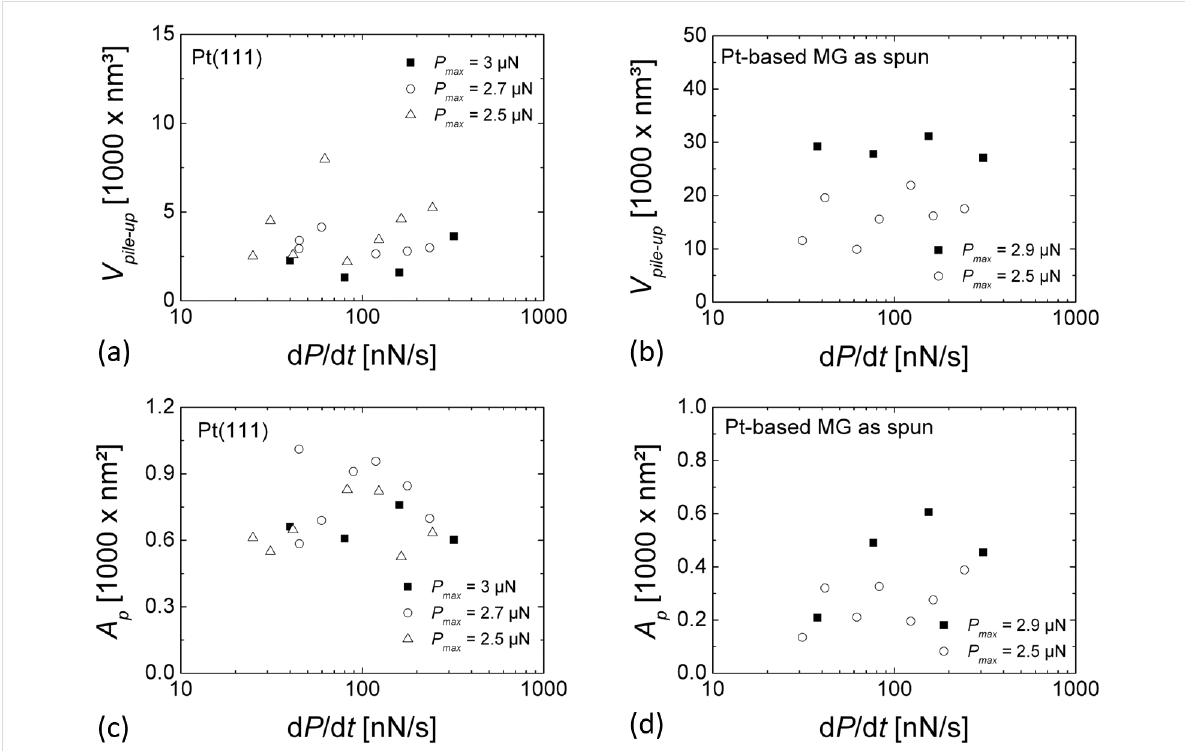
Figure 6: (a,b) Pile-up volume V pile up , (c,d) projected area A p as a function of d P /d t for (a,c) Pt(111) and (b,d) Pt 57.5 Cu 14.7 Ni 5.3 P 22.5 metallic glass, respectively.